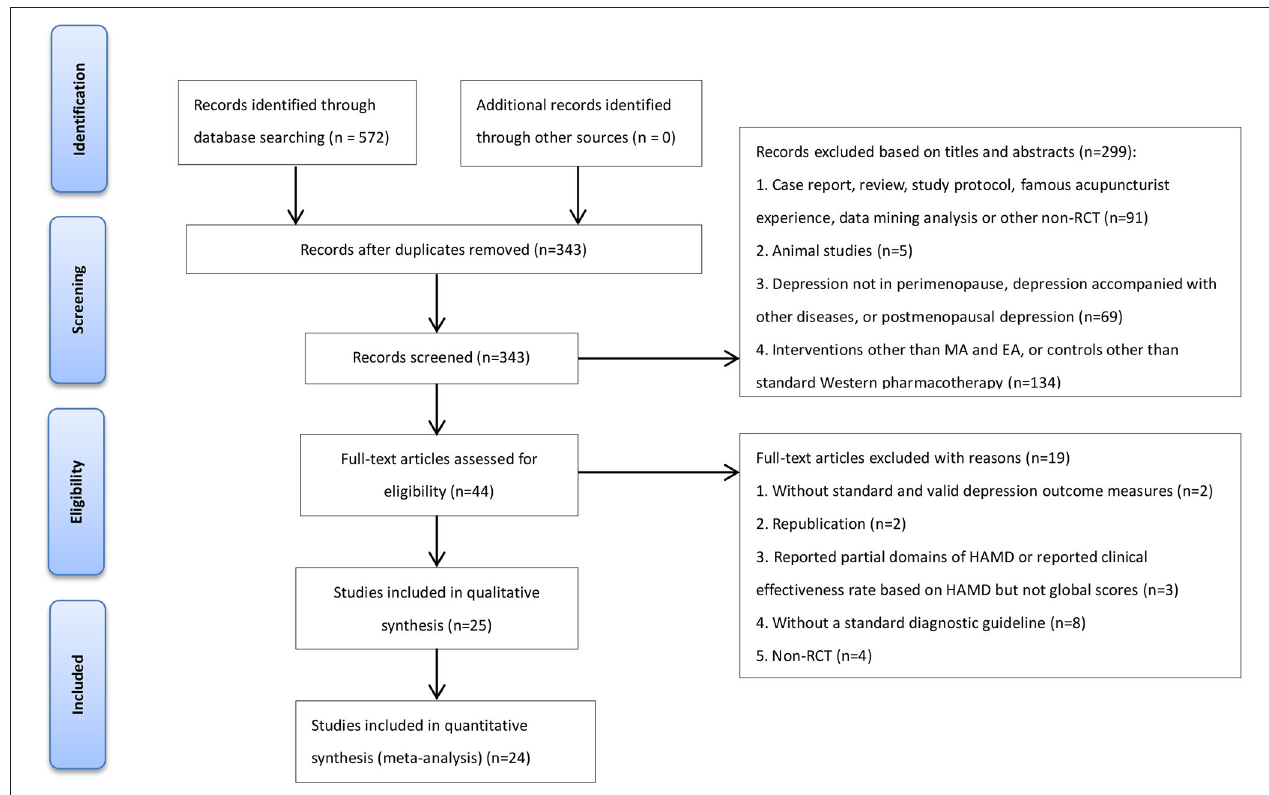
FIGURE 1 | Flow diagram of the study selection process. MA, manual acupuncture; EA, electroacupuncture; RCT, randomized controlled